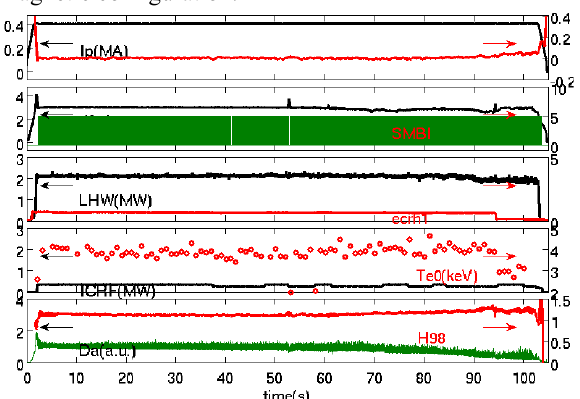
Fig. 15. Time evolution of key signals for the 101s H-mode operation of EAST.